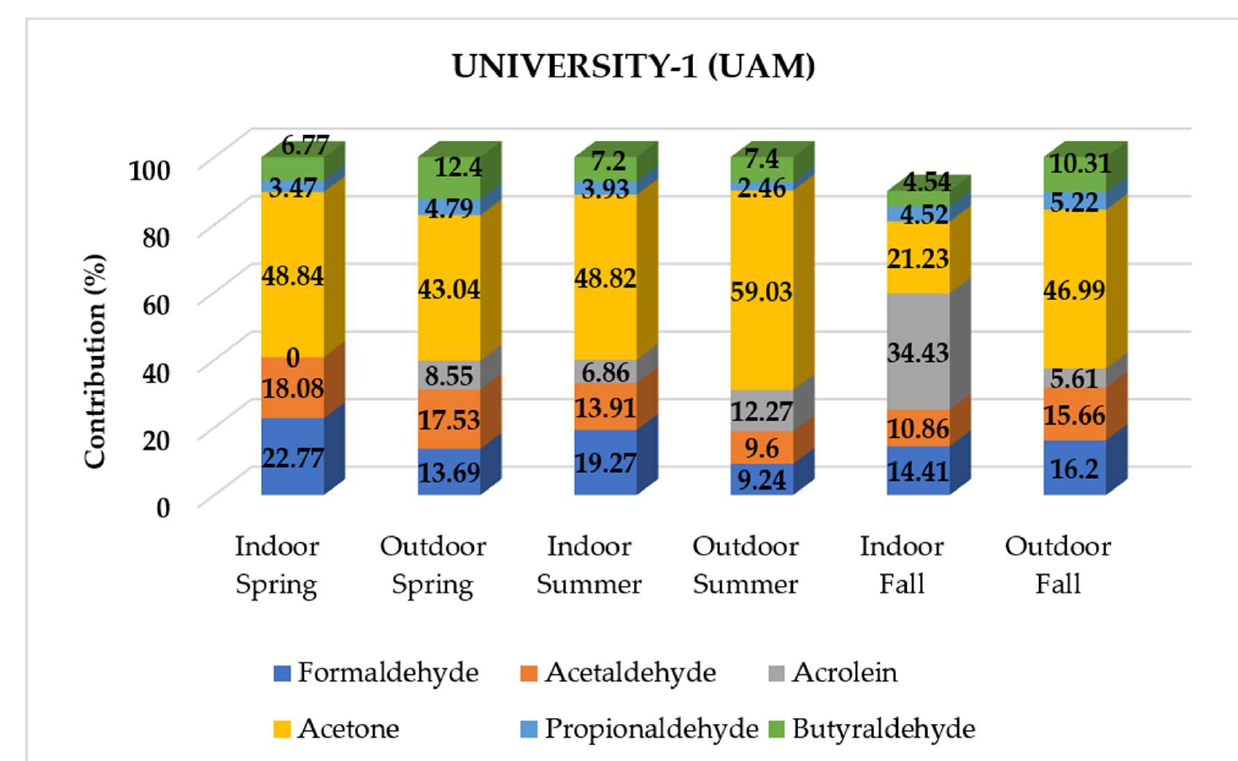
Figure 2. Seasonal variation of the contribution percentage of each carbonyl compound to the total carbonyl concentrations (indoor and outdoor) in University-1 (UAM).